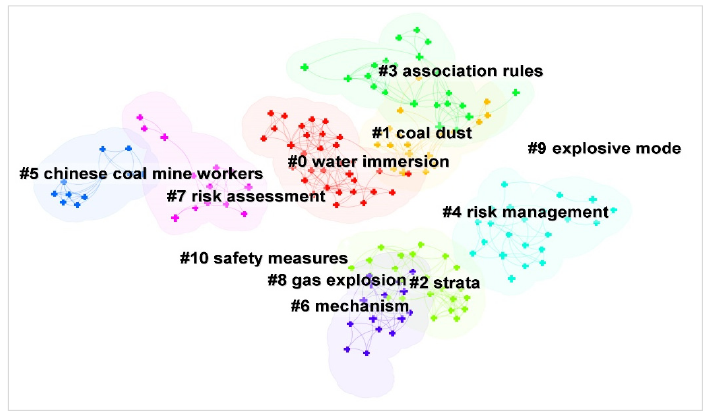
Figure 5. Categories of topics for research on coal mine accidents in China.